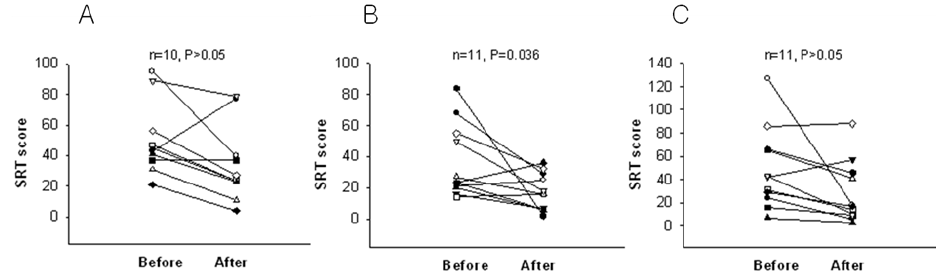
Figure 5. Differences in SRI mean scores between WNS and placebo groups. ( A ) Placebo group, ( B ) 2.4 g of WNS group, ( C ) 4.8 g of WNS group.